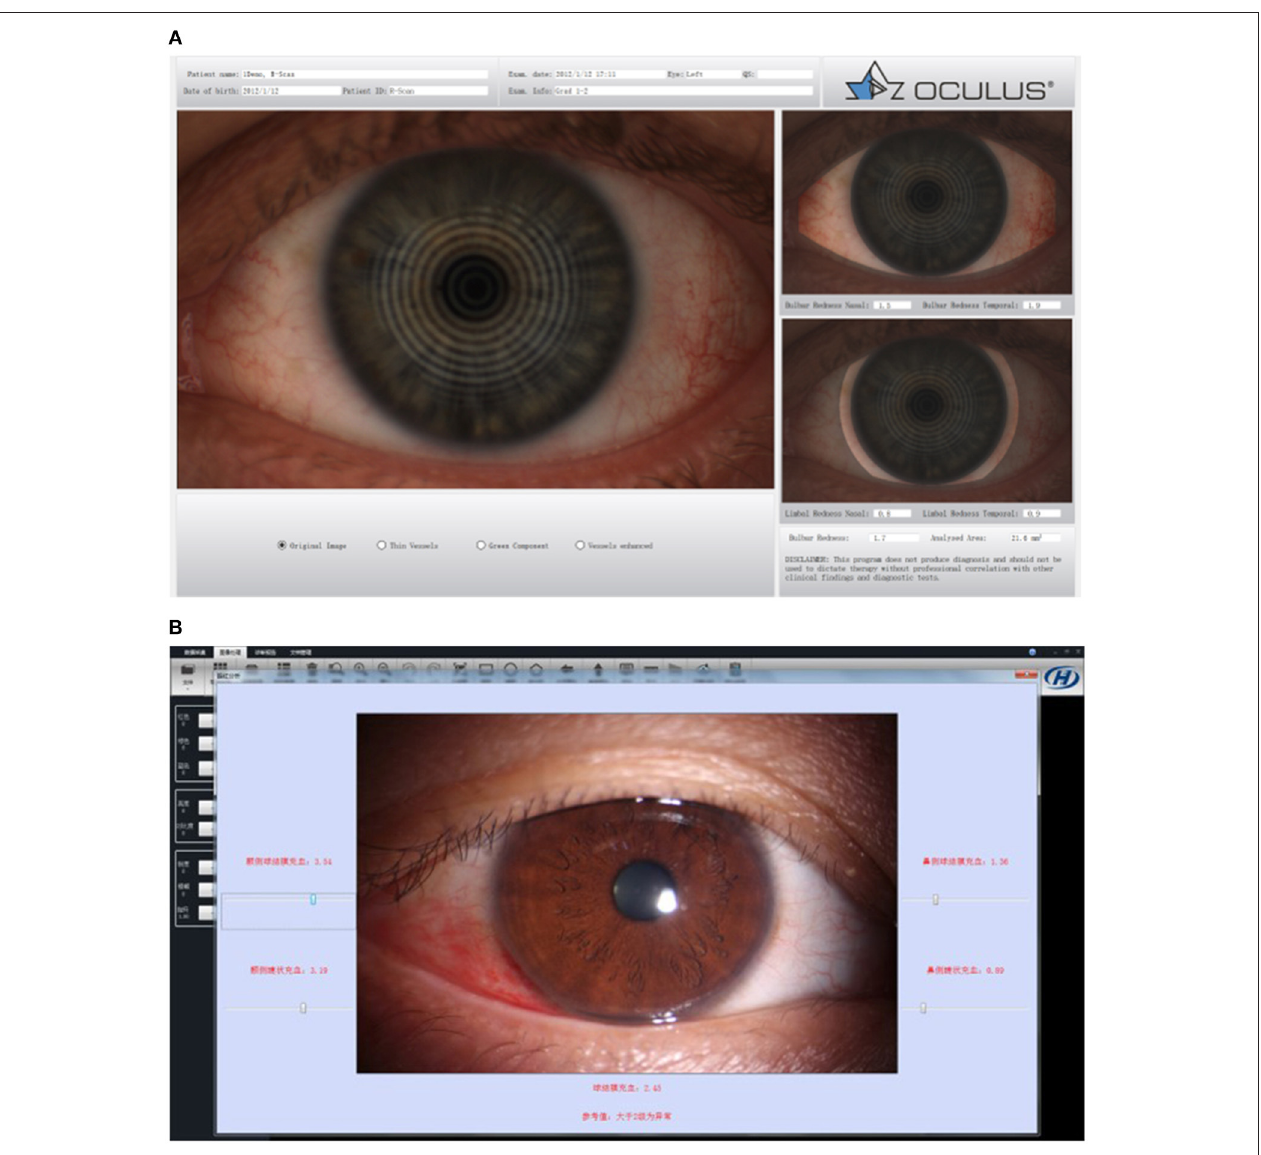
FIGURE 6 | Bulbar redness. (A) OCULUS Keratograph 5M for bulbar redness grading scale. (B) Kanghua dry eye analyzer for bulbar redness grading